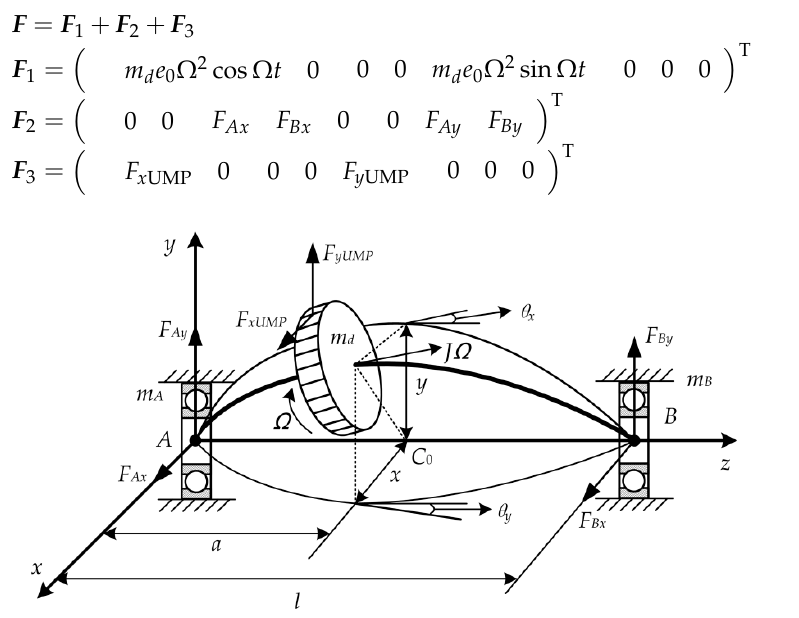
Figure 5. Dynamic model of the rotor bearing system. Table 2. Parameters involved in the